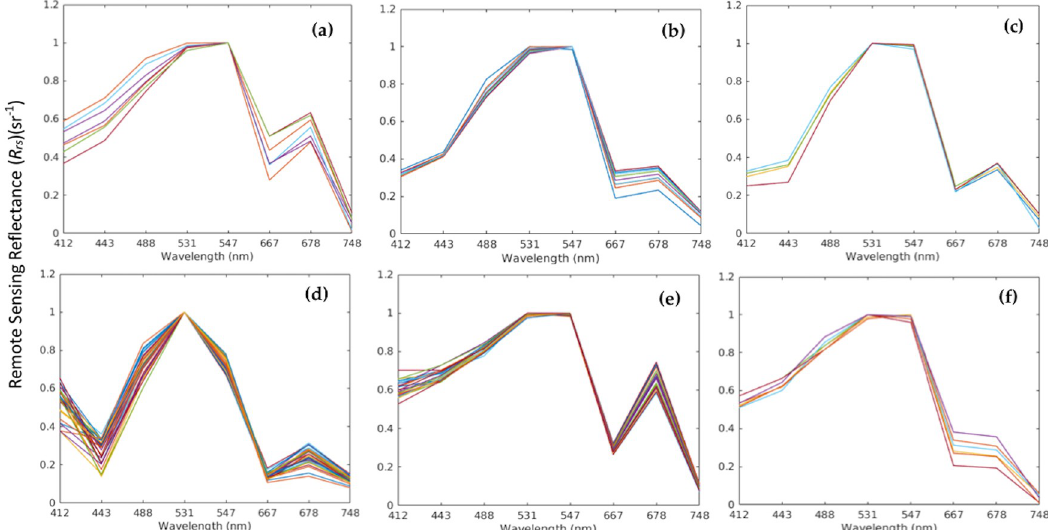
Fig 3. Examples of R derived from daily MODIS-Aqua data for the different HAB species in the Red Sea waters. (a) H . rs akashiwo (b) Ostreopsis sp . (c) K . foliaceum (d) N . scintillans/miliaris (e) C. polykrikoides (f) T . erythraeum